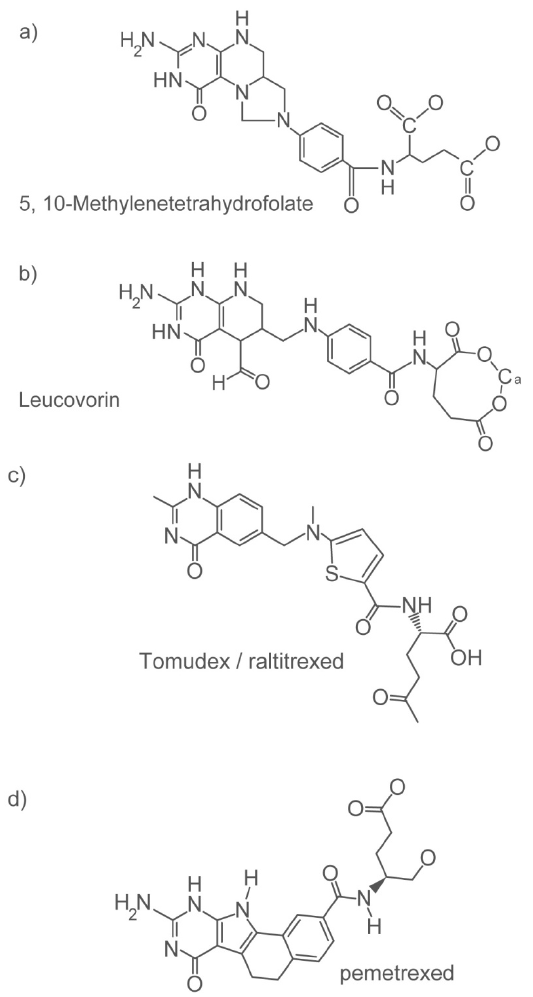
Figure 1. Chemical structures of ( a ) 5,10-methylene-THF, ( b ) leucovorin and the antifolate inhibitors ( c ) tomudex and ( d )